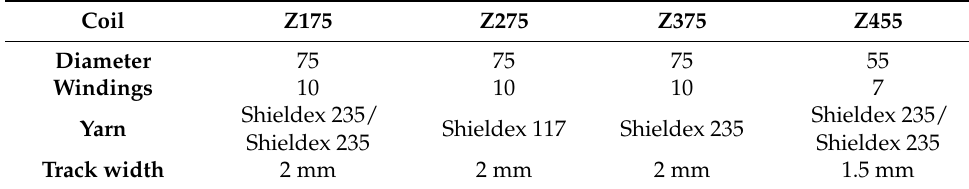
(Z455) of this type has a diameter of 55 mm and seven turns with a track width of 1.5 mm. Table 2. Overview of embroidered coils with Shieldex yarns—test series Z Table 2. Overview of embroidered coils with Shieldex yarns—test series Z. Table 2. Overview of embroidered coils with Shieldex yarns—test series Z